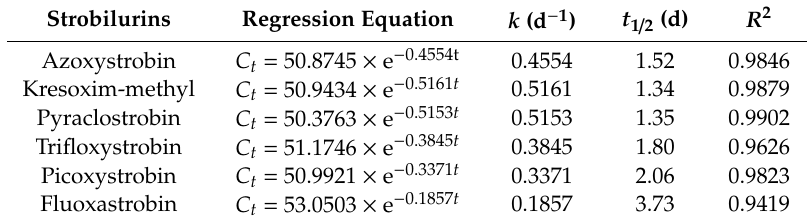
Table 4. Kinetic parameters of various strobilurin fungicides degradation by strain SH14.